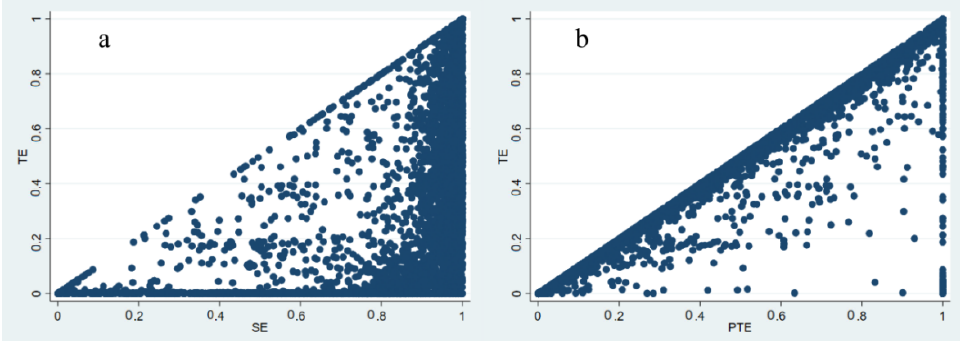
Figure 4. The contribution of ( a ) PTE to TE and ( b ) SE to TE.